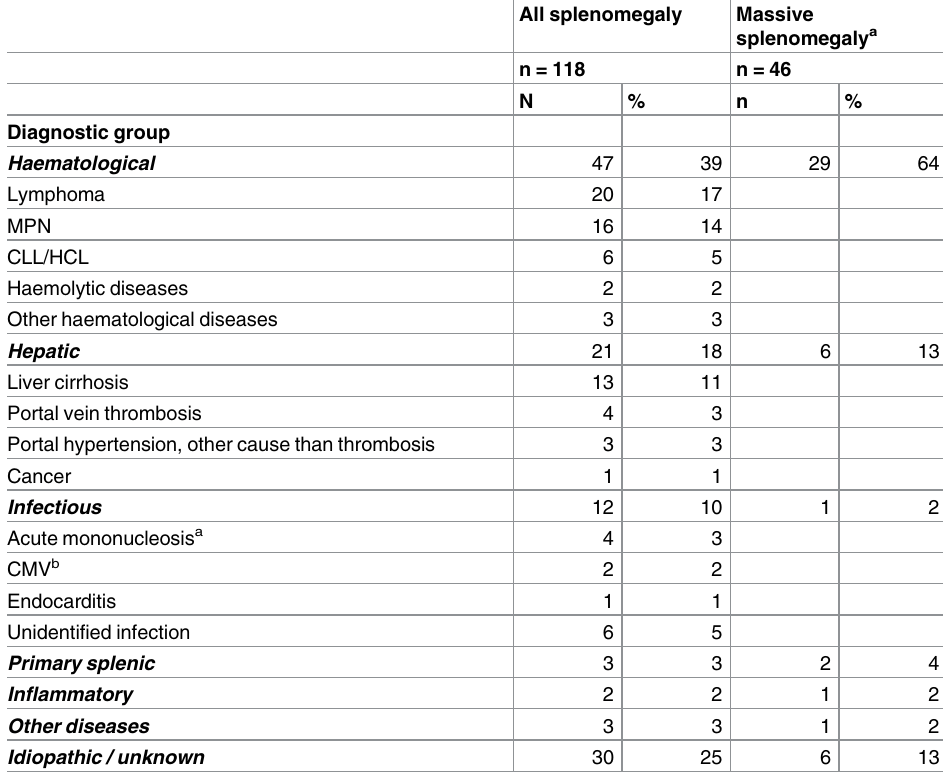
their splenomegaly. Among patients with massive splenomegaly, haematological diseases were the most common causal diagnosis (64%), while 13% had no underlying diagnosis. The distribution of diagnostic groups, comparing patients diagnosed with splenomegaly in the years of 1994–2003 (1 st decade) and 2004–2013 (2 nd decade), can be seen in Fig 1. The total Table 2. Causal